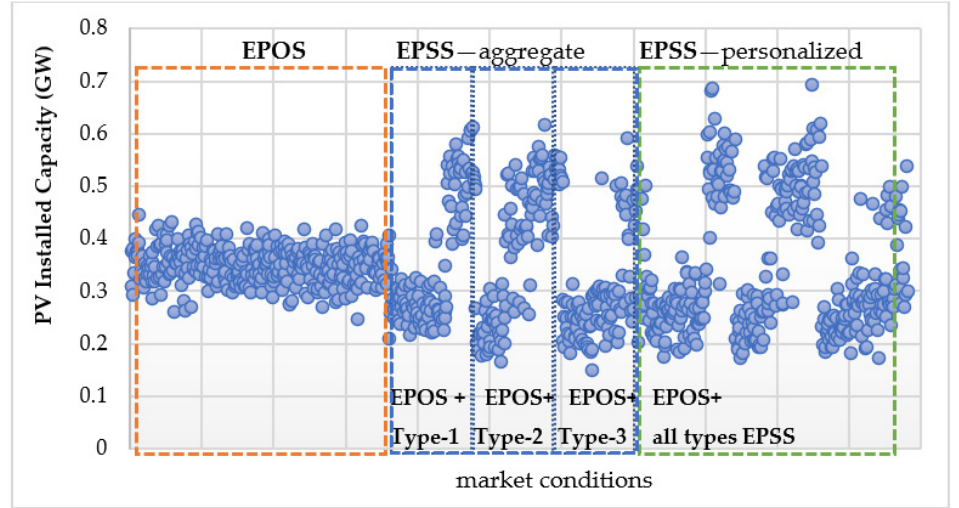
Figure 2. Market condition effect on PV installed capacity. (Data can be found in the Supplemen- tary